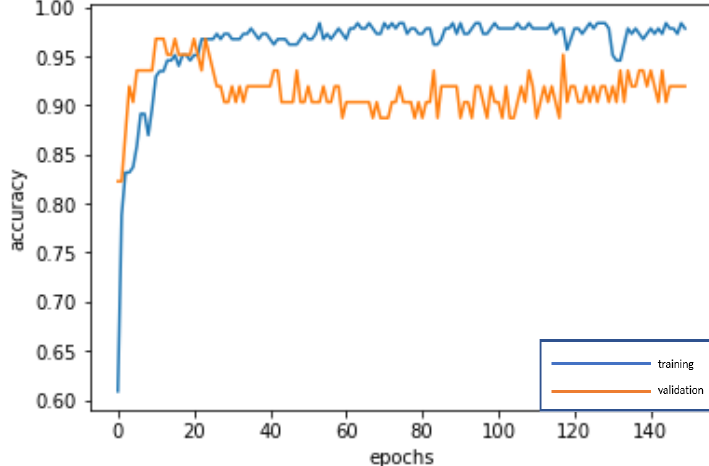
Figure 7. Accuracy line graph of the CART-DNN modeling.